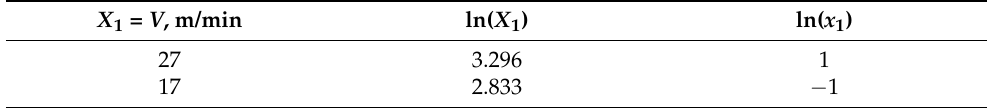
Table 2. Encoded values of cutting speed V .